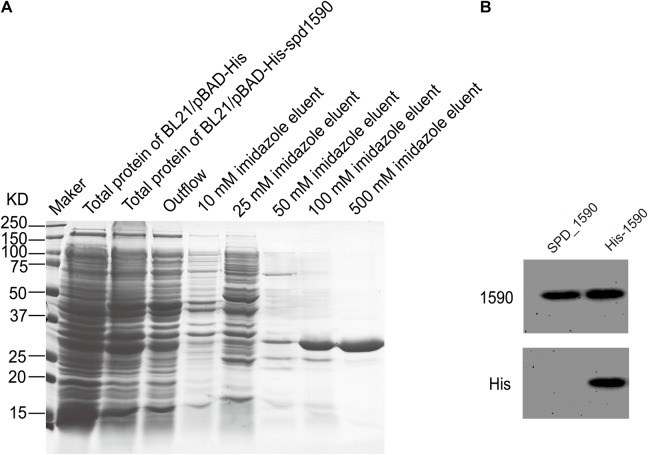
The purification of SPD_1590. (A) SPD_1590 was expressed with pBAD-His fusion system and purified by Ni-NTA column. (B) Western blotting assay for SPD_1590 expression using anti-SPD_1590 and anti-His6 antibody.